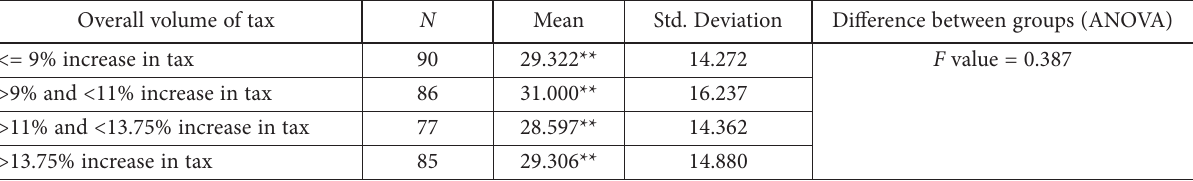
Table 6. Association between the aggregate tax rate and the incidence of under-invoicing (source: author’s calculation) Overall volume of tax N Mean Std. Deviation Difference between groups